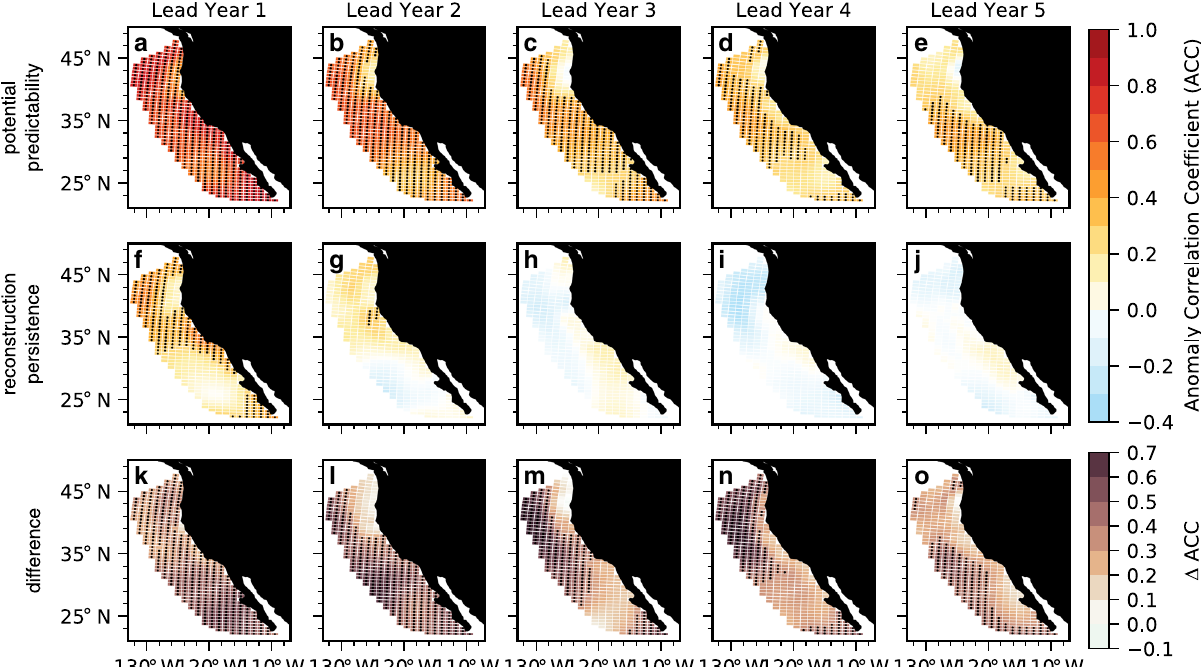
Fig. 3 Potential predictability of surface pH anomalies. a – e Anomaly correlation coef fi cients (ACCs) for Community Earth System Model Decadal Prediction Large Ensemble (CESM-DPLE) initialized forecasts of detrended annual surface pH anomalies for lead years one through fi ve correlated with the reconstruction. f – j Persistence forecast for the reconstruction for lead years one through fi ve. Stippling in a – j denotes statistically signi fi cant correlations at the 95% level using a t test. An effective sample size is used in the t test to account for autocorrelation in the two time series being correlated. k – o Difference between the CESM-DPLE forecast ACCs and persistence ( Δ ACCs). Stippling indicates that the initialized prediction is statistically signi fi cant over the persistence forecast at the 95% level using a z test. Only positive ACCs and Δ ACCs are